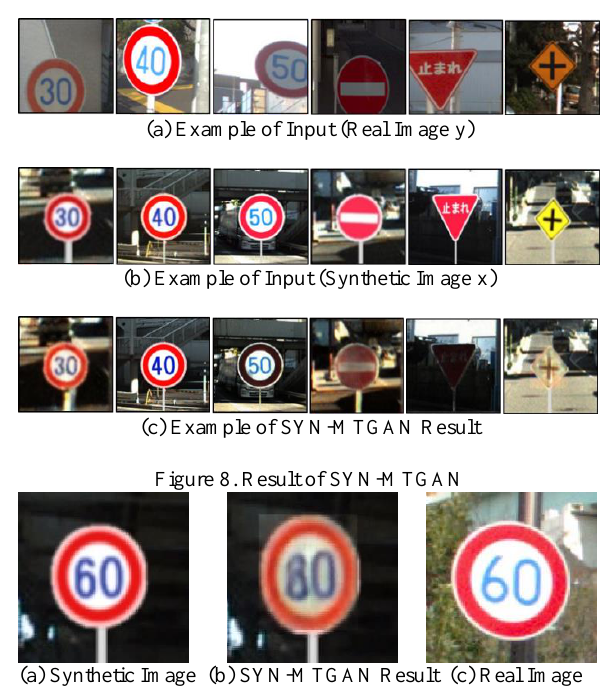
Figure 9. Example of the Sign of Speed Limit of 60